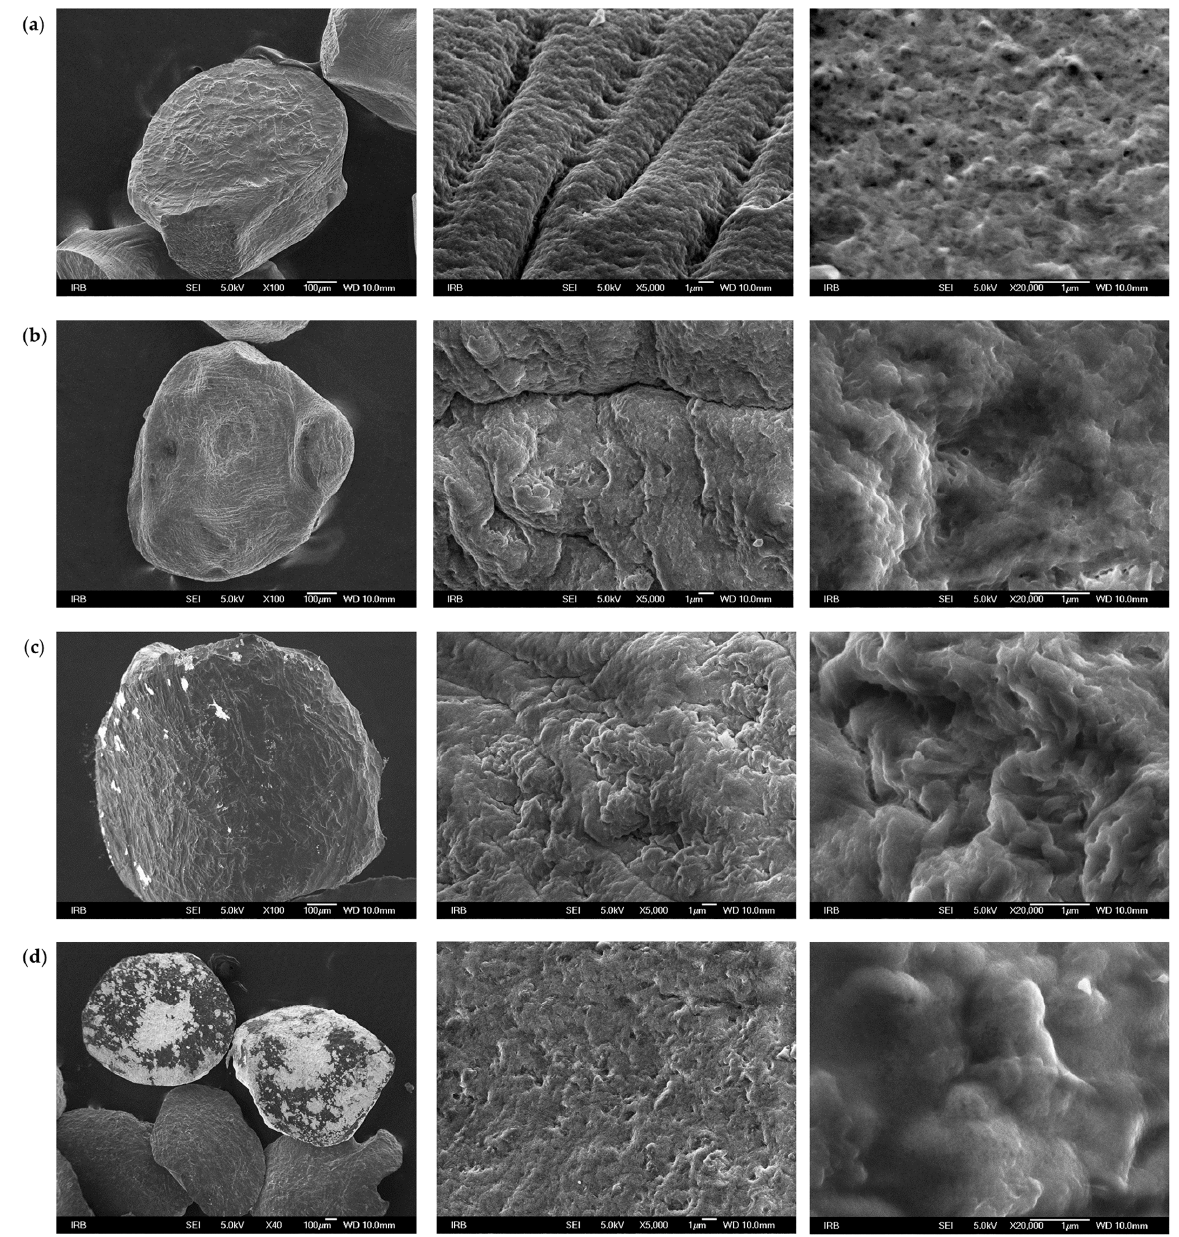
Figure 3. SEM microphotographs of ( a ) Alg ( b ) Alg/Z ( c ) Alg/HPMC, and ( d ) Alg/Z/HPMC microparticles loaded with distilled water. Bars are indicated.